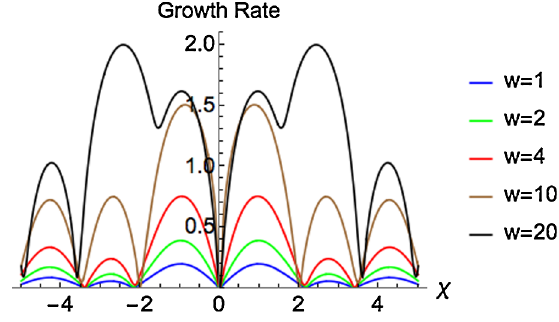
FIG. 6. Same for the